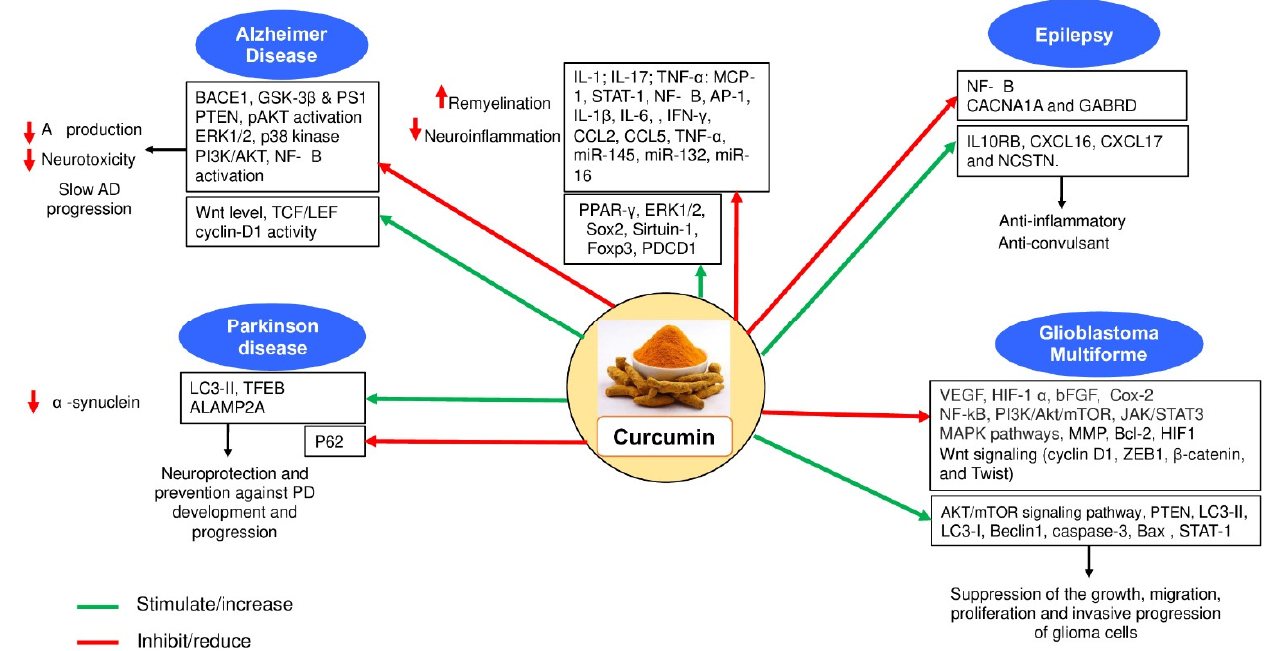
Figure 2. Molecular mechanisms by which curcumin exerts its therapeutic effects on neurological